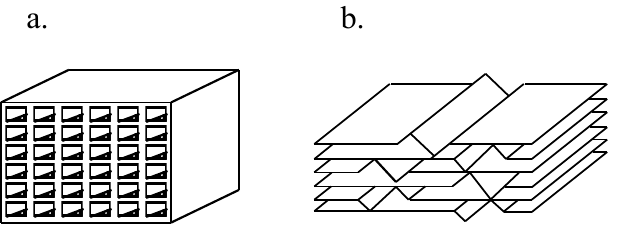
Figure 38. SCR catalyst support geometries: ( a ) extruded ceramic monolith; and ( b ) plate. Reproduced from [8]. Copyright 2006,